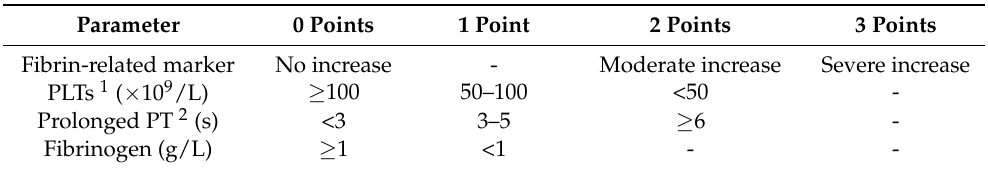
Table 2. International Society on Thrombosis and Hemostasis disseminated intravascular coagulation diagnostic scoring system. Based on [3].